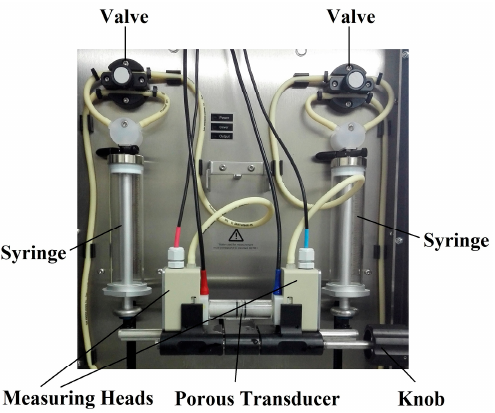
Figure 3. Instrumentation of the permeability measurement (SurPASS, Anton Parr Co., Graz, Austria).